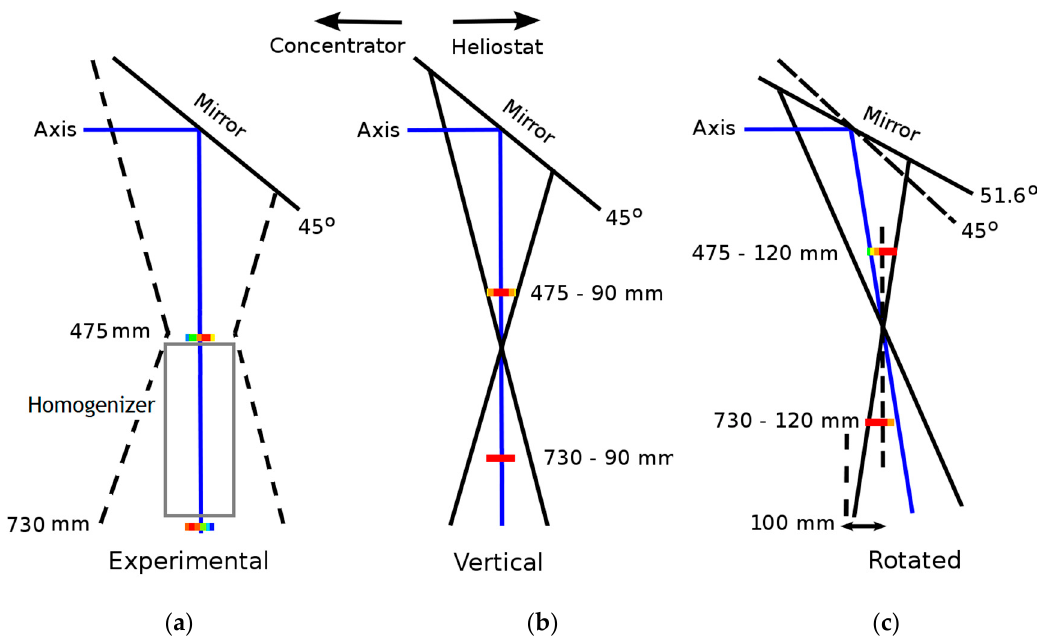
Figure 4. Geometry of the experimental ( a ) and modelling ( b , c ) measurements obtained for planes 475 and 730. The colour profiles shown for the two detectors emulate the values obtained for experimental (Figure 5) and modelling data (shown later in Figures 7 and 9).